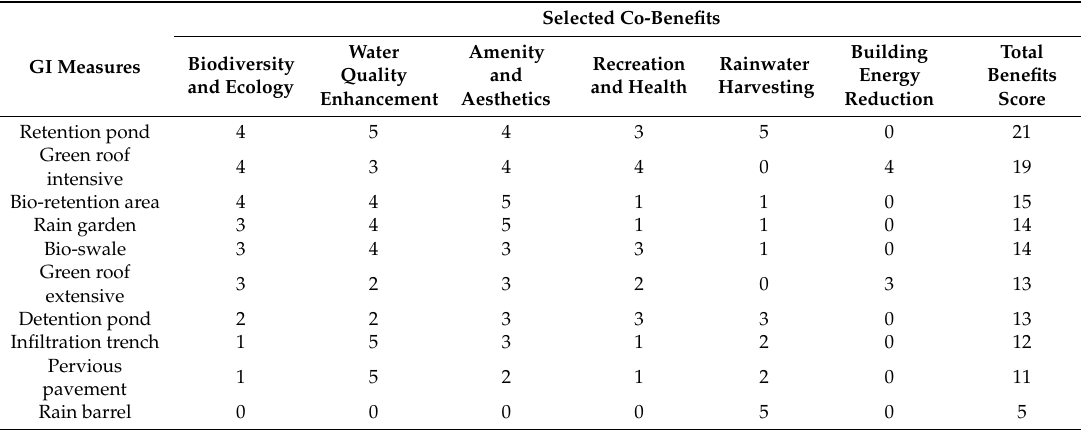
Table 4. Ranking of GI measures according to their impact on selected